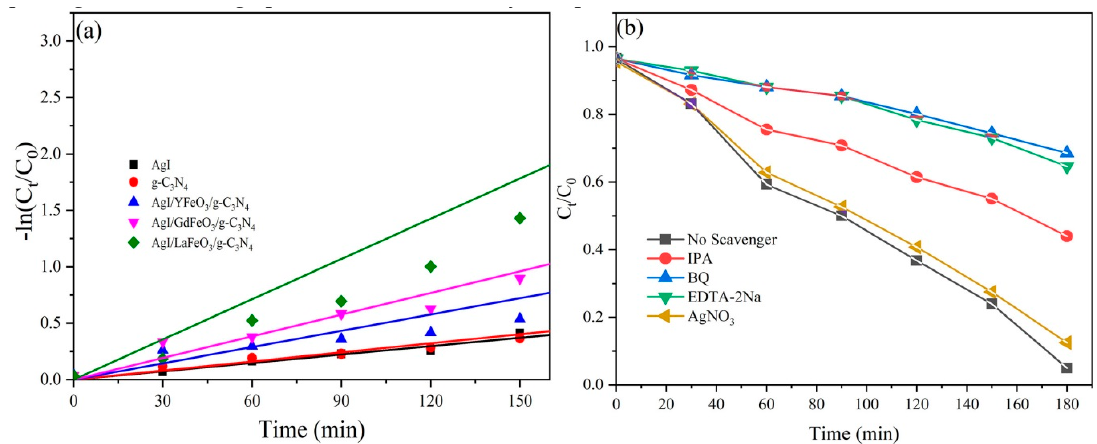
Figure 8. ( a ) Reaction kinetics of photocatalytic degradation of AgI/MFeO 3 /g-C 3 N 4 (M = Y, Gd, La) and ( b ) radicals quenching experiments.